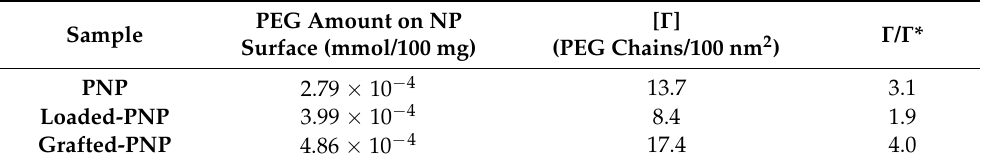
Table 2. Amount of PEG moieties on the NP surface, surface PEG density [ Γ ]. Number of PEG per 100 nm 2 and ratios of PEG density to full surface coverage [ Γ / Γ *] of PNP, loaded-PNPs